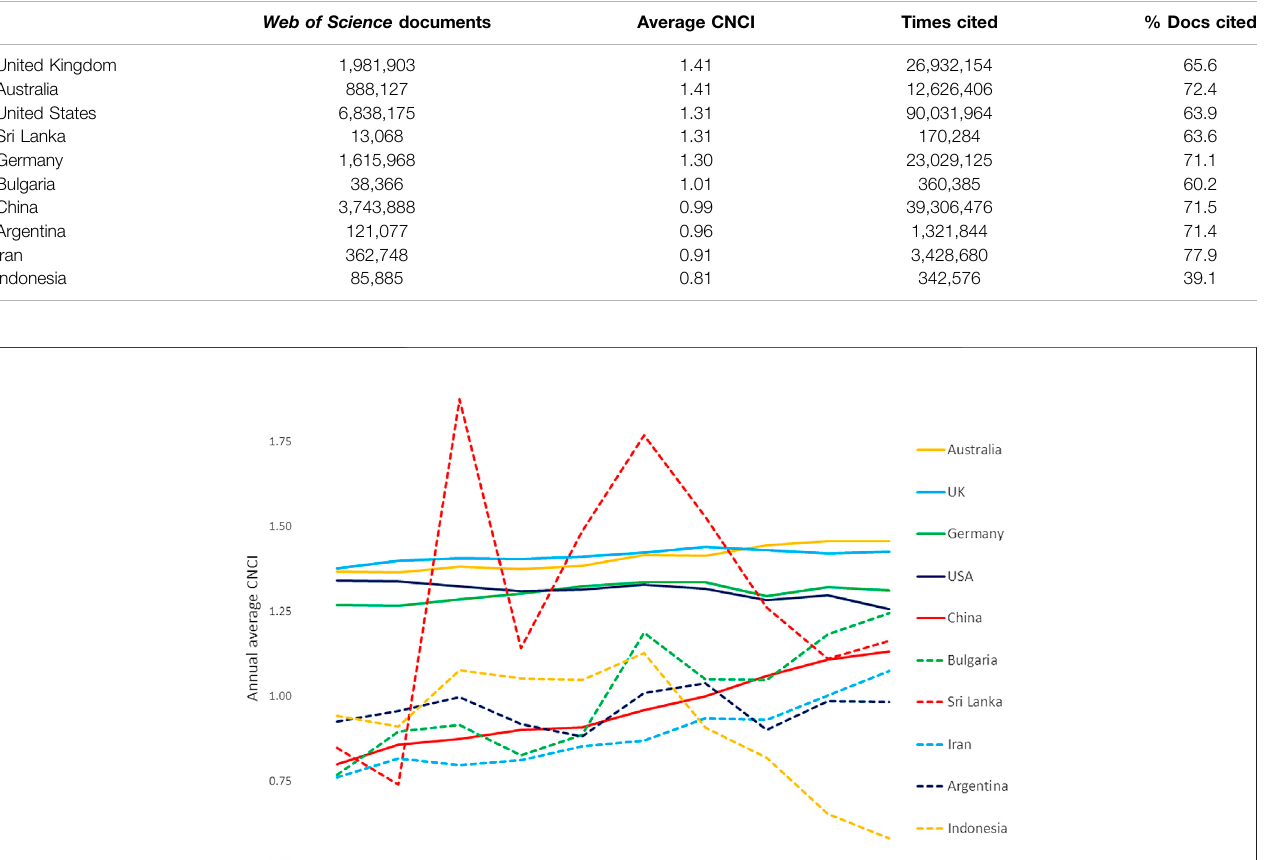
TABLE 1 | Summary metrics for the research production (numbers of documents indexed in the Web of Science ) and performance (category normalized citation impact, CNCI world average (cid:1) 1.0) of a global spread of ten countries during a recent ten-year period (2010 – 2019). Countries are ranked on